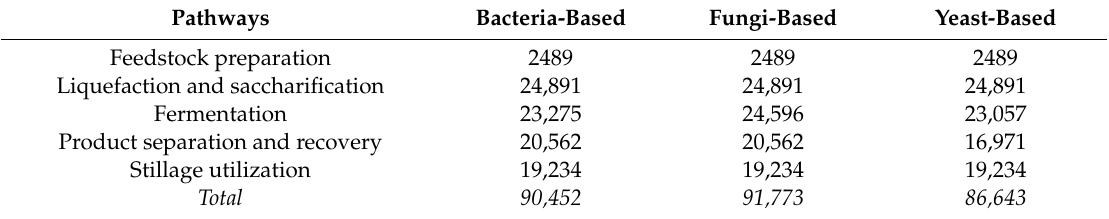
Table 4. Labor requirements (h / year) for di ff erent pathways of lactic acid production from corn grain. Pathways